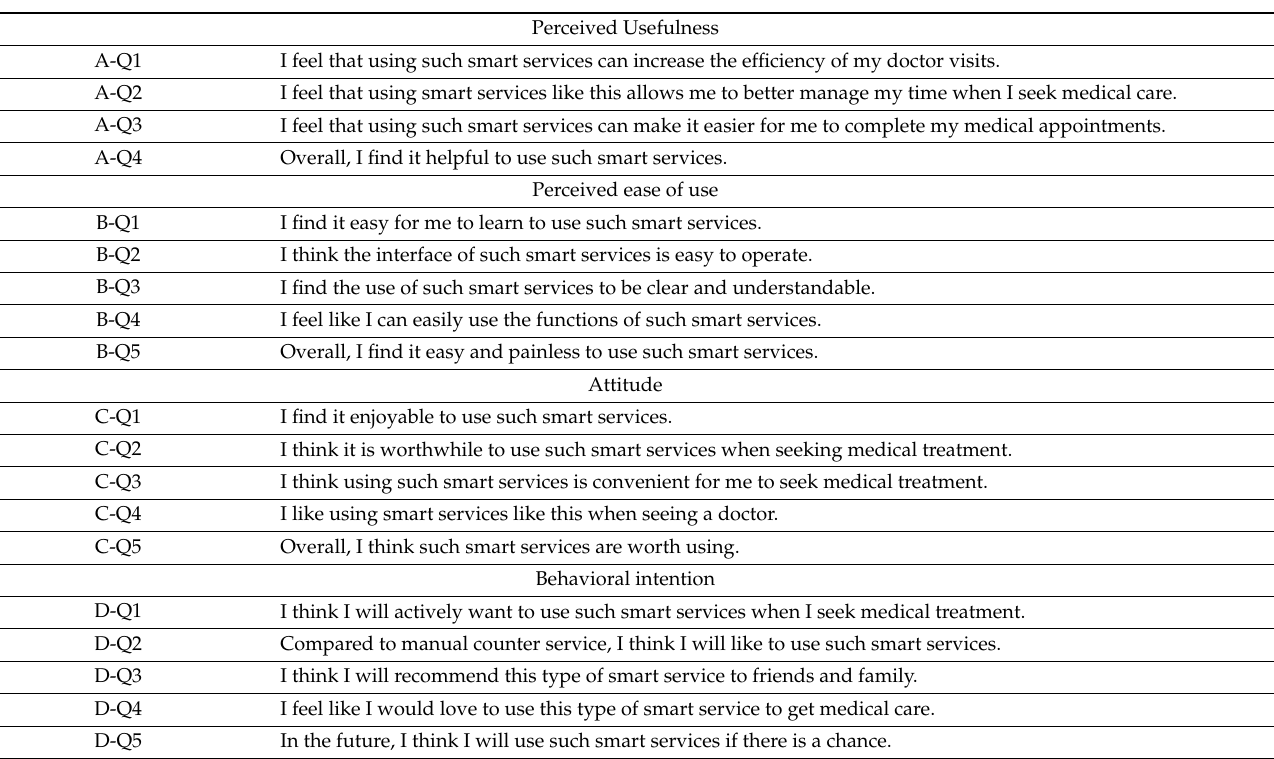
Table 5. Questionnaire